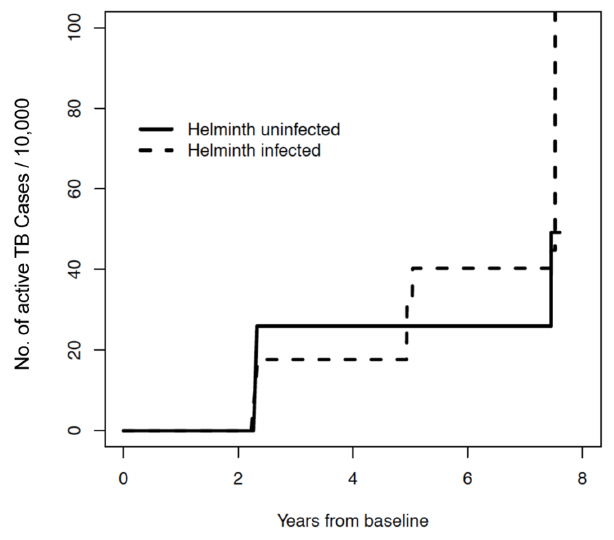
Figure 2. Time to development of active TB (in years) in helminth-infected (dotted line) and helminth-uninfected (solid line) subjects using nonparametric maximum likelihood esti- mates.